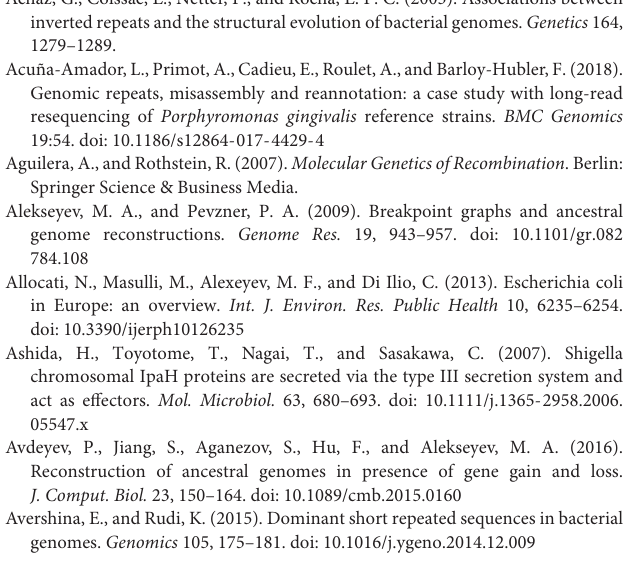
Supplementary Figure 2 | Construction of breakpoint graph. (a) Genome graphs of unichromosomal circular genomes P = (0, 1, 2, 3, 4, and 5) and Q = (0, 1, − 4, − 3, − 2, and 5), the adjacency edges of the genome P (left) are shown in blue, the